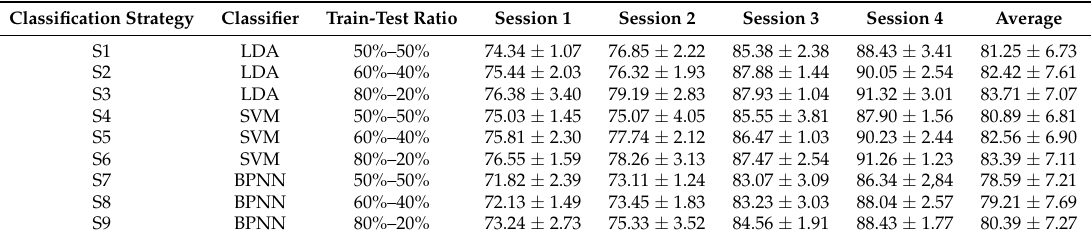
Table 2. The classification accuracies of nine classification models based on different classification strategies for each session across all subjects (in %).